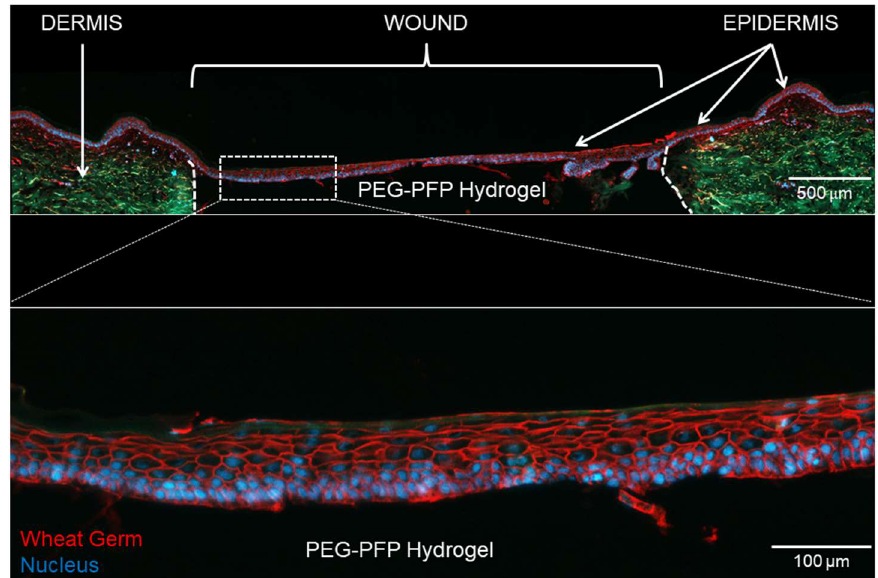
Figure 2. Re-epithelialization of 4 mm ex vivo explant. Top : An explant treated with polyethylene glycol-platelet free plasma (PEG-PFP) hydrogel for 14 days was cryopreserved in a sucrose gradient, sectioned, and stained with wheat germ (WG, red) to visualize all plasma membrane surfaces and counterstained with 4′,6-diamidino-2-phenylindole ( DAPI) for nuclei (blue). The white dotted line represents the boundary between normal dermis (green auto-fluorescence) and the wound. Bottom : Enlarged image shows the multilayer epidermis (6–8 cell layers thick) that formed over the PEG-PFP hydrogel.